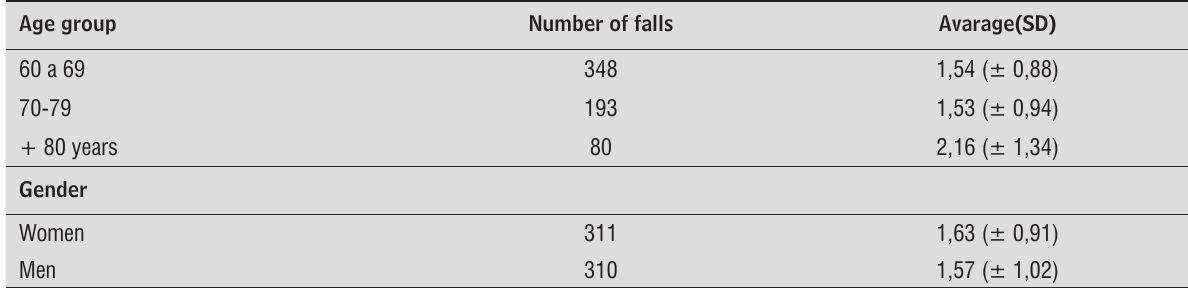
Tabela 5 – Falls at home by age group and gender